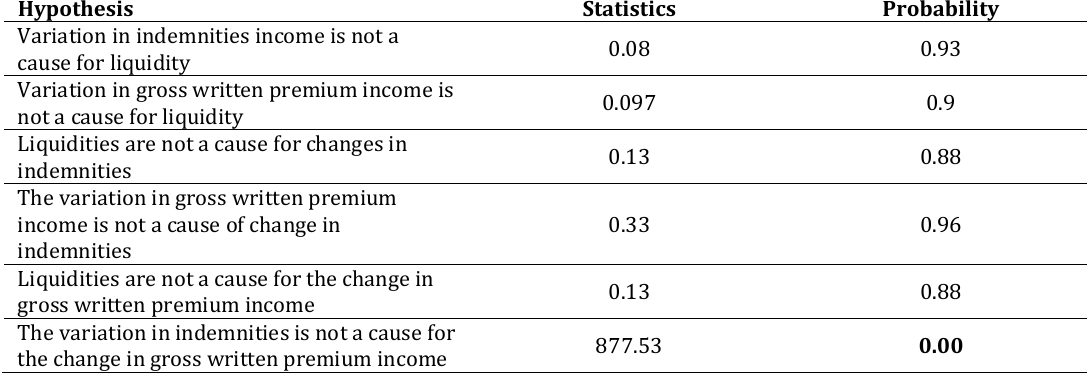
Table 1: Granger test for causal relationships between stationary data variables Hypothesis